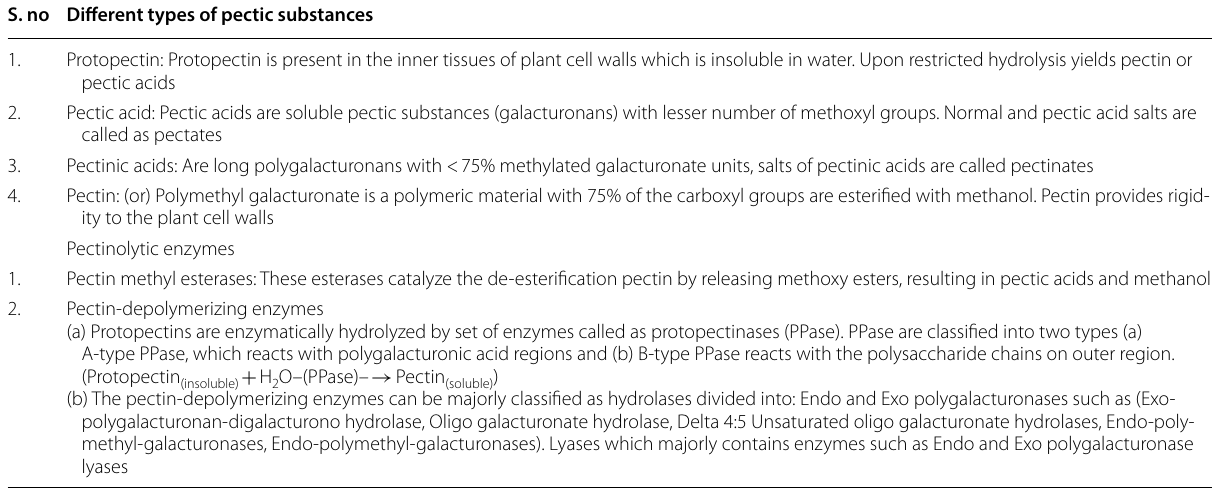
Table 2 Different types of pectic substances and pectinolytic enzymes responsible for its degradation